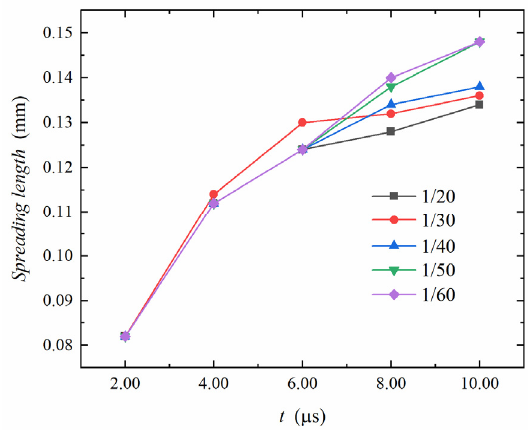
Figure 3. Droplet spreading length with different grid sizes.